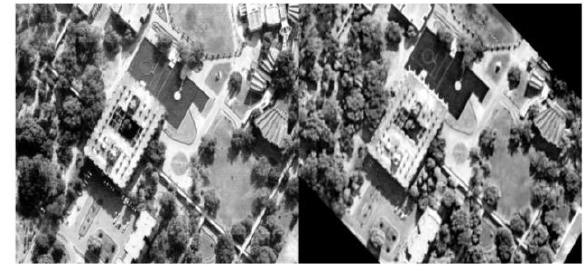
Figure 7. Aerial Image (left) and Google Earth (right) of Library